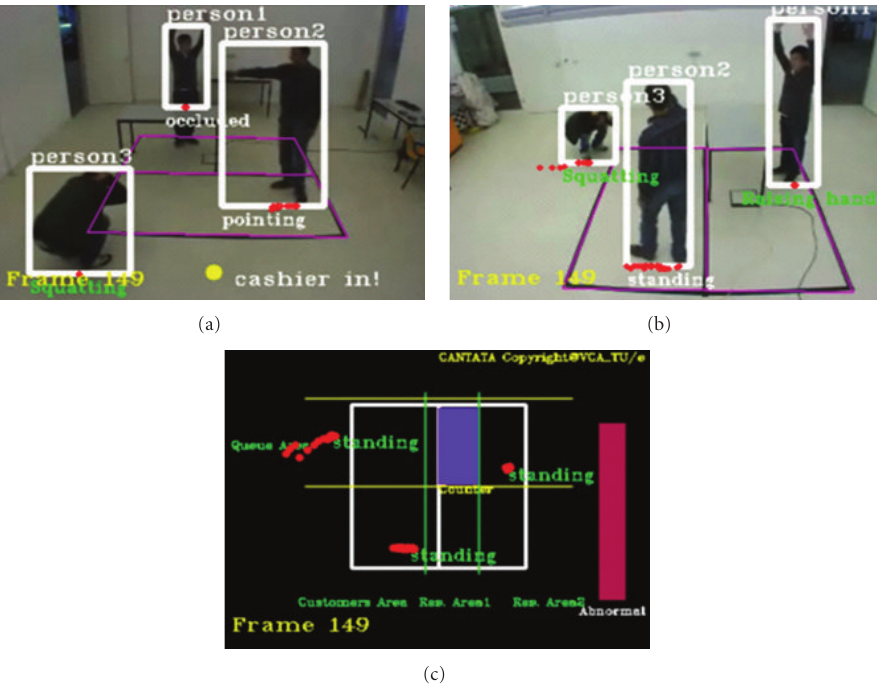
Figure 7: Example of our simulated multicamera robbery-detection